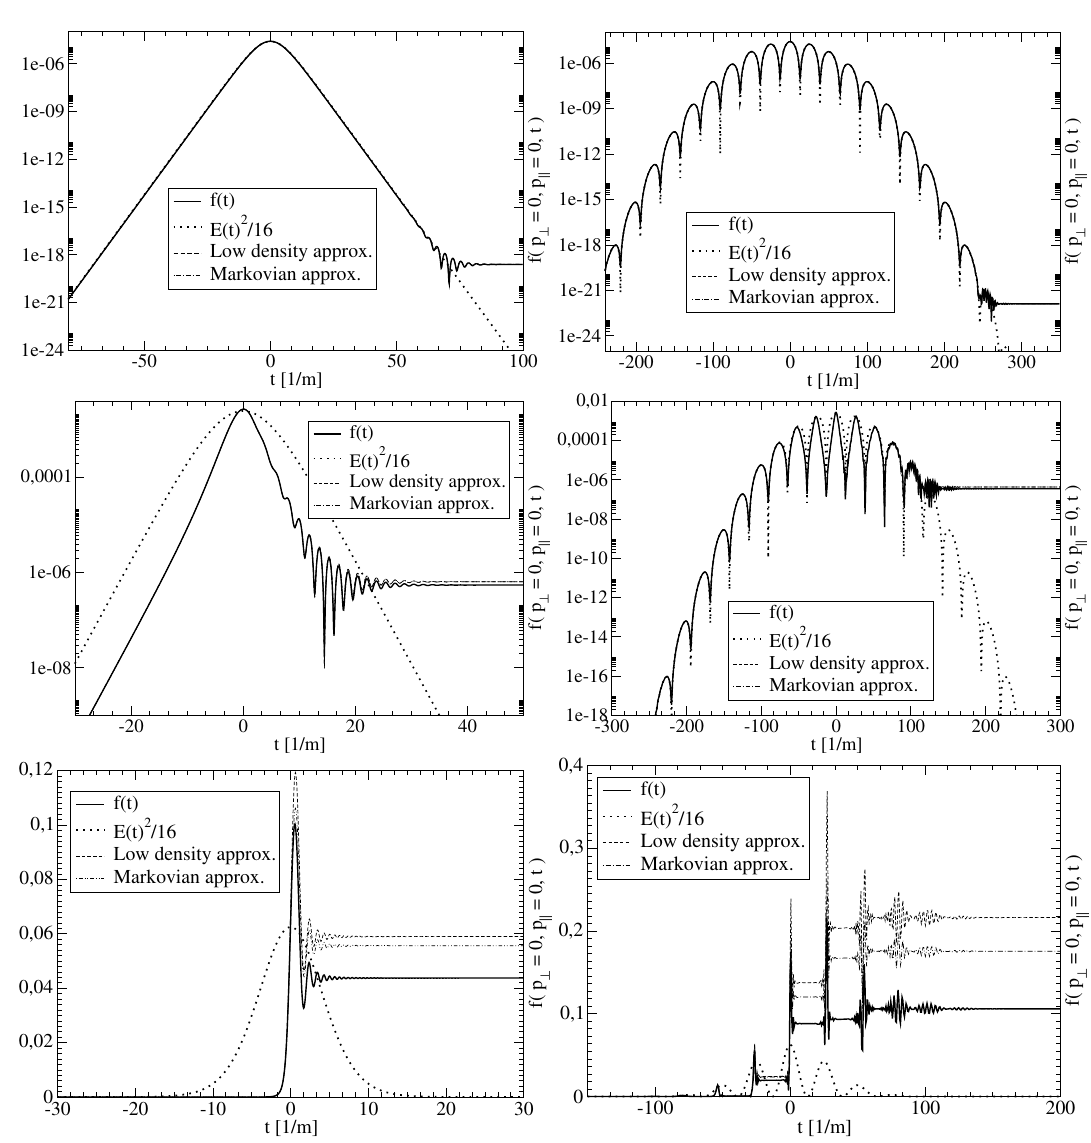
Figure 1. Time evolution of the fermionic distribution function f ( p ⊥ = 0, p (cid:107) = 0, t ) . Left panels: for the Sauter pulse (32) with τ = 8. Right panels: for the Gaussian envelope harmonic (GEH) pulse (33) with σ = 5, ϕ = 0 and ω = 0.02 nm. From the upper to the lower panel the electric field increases as E 0 / E c = 0.02, 0.2, 1. Time is scaled with the electron mass. Solid curve: full solution f ( t ) , dotted curve: E ( t ) 2 /16, dashed curve: low density approximation f 0 ( t ) given by (23), dot-dashed curve: Markovian limit f M ( t ) given by